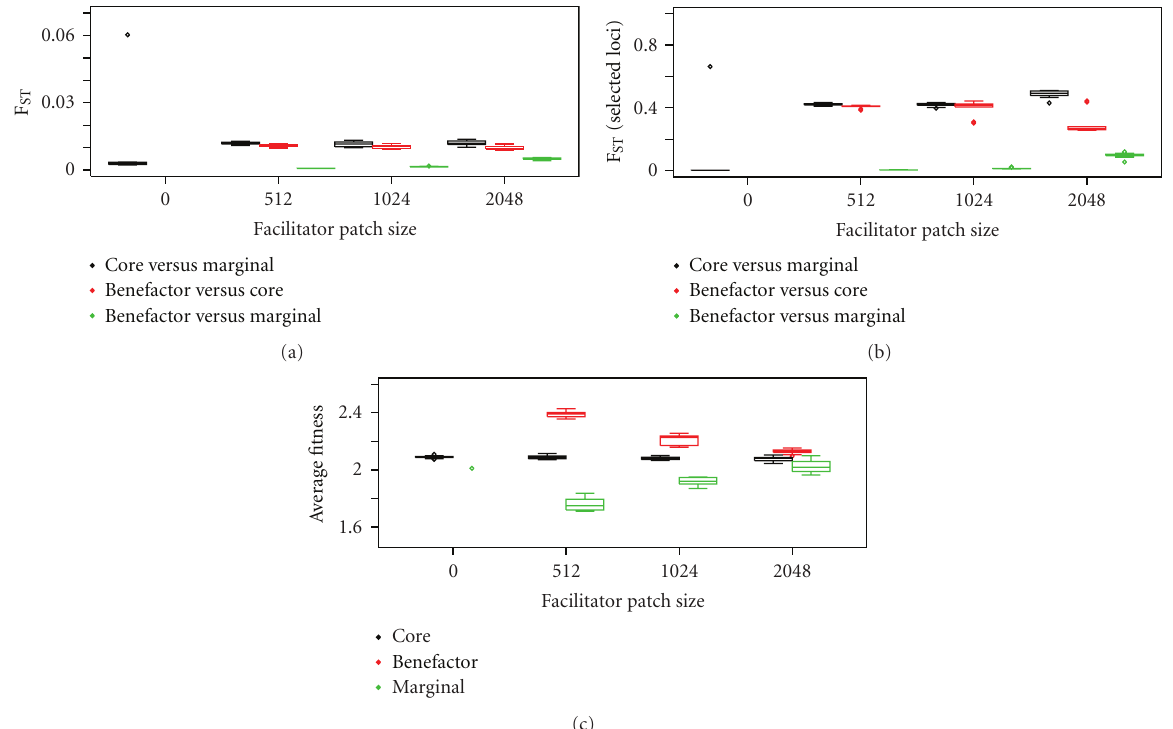
Figure 4: How facilitation may act as a stepping stone for ecological speciation. We looked at that question by increasing the environmental di ff erence between core and marginal habitats. (a) represents the population divergence at neutral loci with either no benefactor or di ff erent patch sizes of benefactor in the marginal environment. (b) represents the divergence at selected loci. (c) represents the average fitness in each environment for these two scenarios. The same model and parameters as in Figure 2 were used, except that we increased environmental di ff erence between core and marginal habitats (Box 1). Without benefactor, no population can establish in the marginal environment that is too harsh for migrants to persist. Only dispersers can be observed there, except in one occasion of actual colonization (outlier at patch size of 0). In presence of benefactors, all environments are occupied by locally adapted populations and gene flow among environments is reduced. Small patch sizes will increase dispersal between the benefactor and marginal environment as in Figure